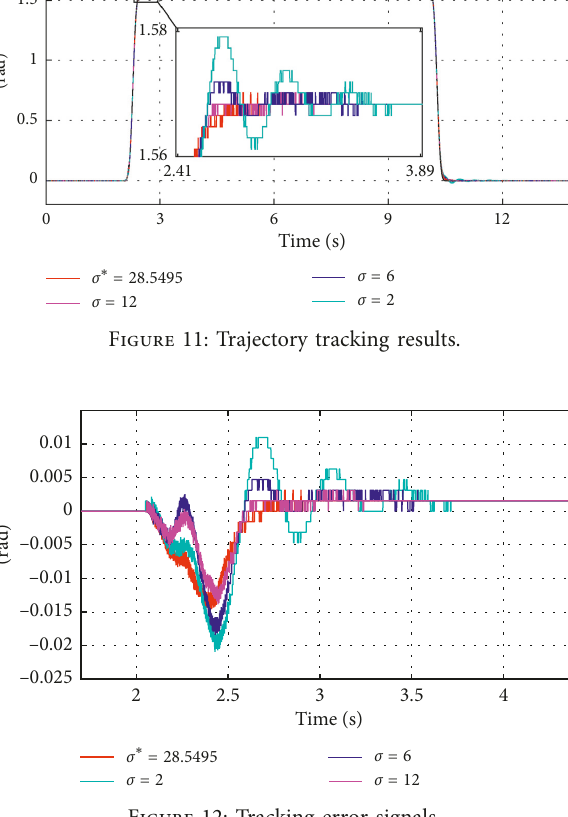
Figure 12: Tracking error